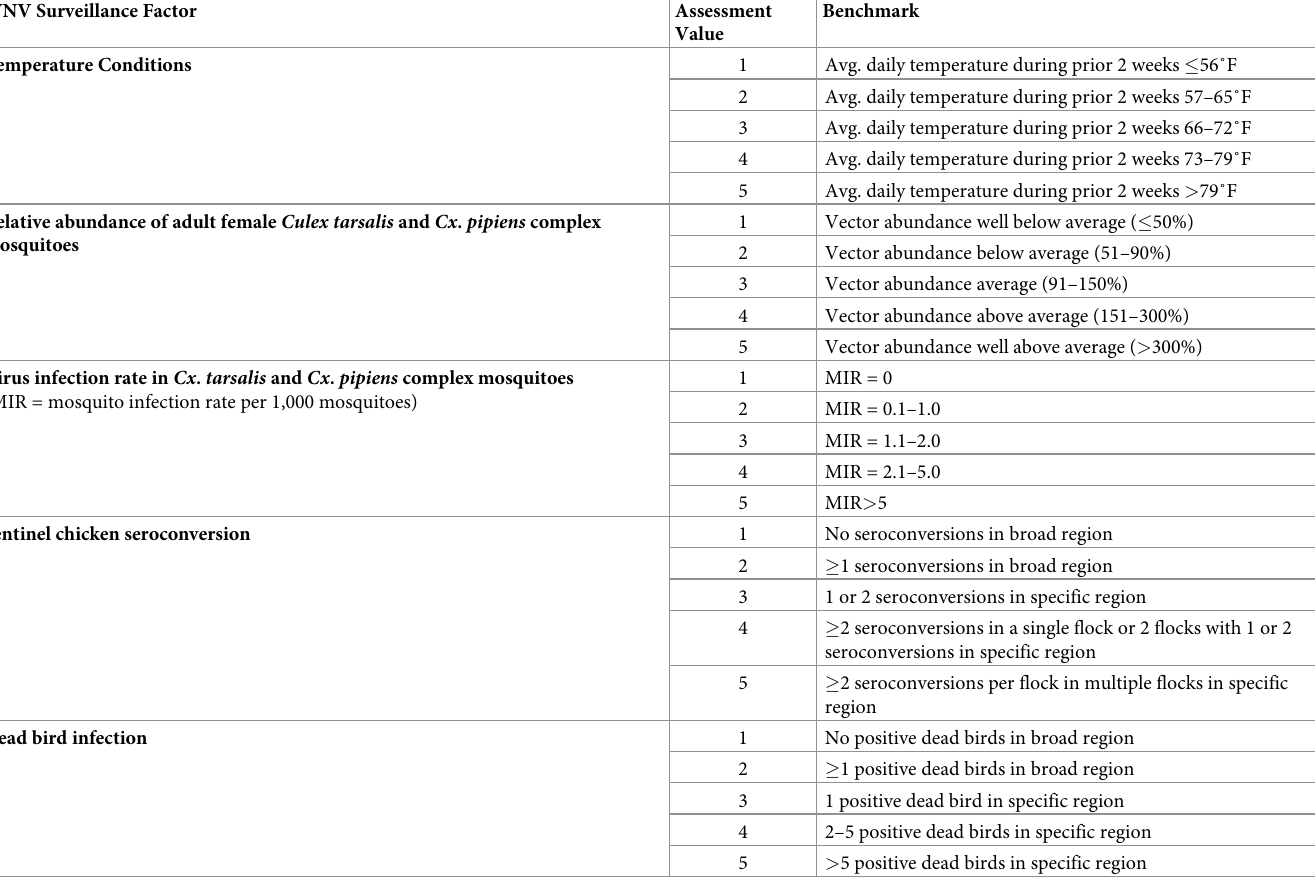
Table 1. Mosquito-Borne Virus Risk Assessment for West Nile virus, from the California Mosquito-Borne Virus Surveillance & Response Plan, by California Department of Public Health, Mosquito & Vector Control Association of California, and University of California, published May